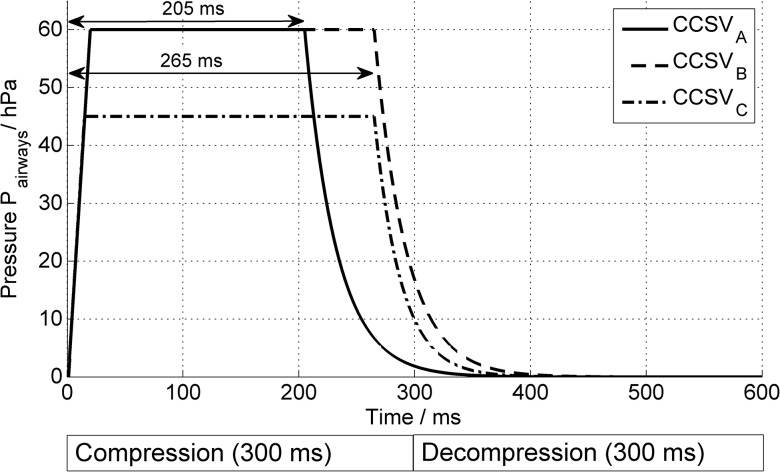
Pressure-time-curves of CCSV.Pressure-time-curves of the three presets of Chest Compression Synchronized ventilation CCSVA, CCSVB, and CCSVC depending on compression-decompression-cycle.